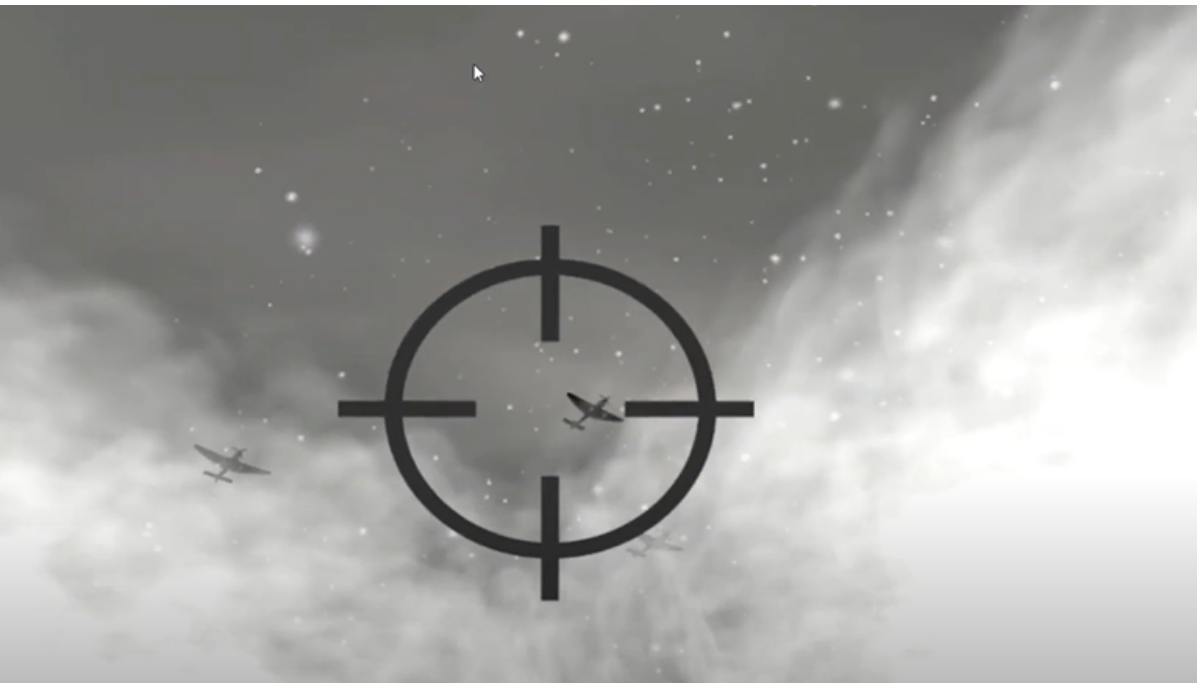
Figure 4. Target for aircraft shooting and their contribution to immersion on the Battle on Neretva VR